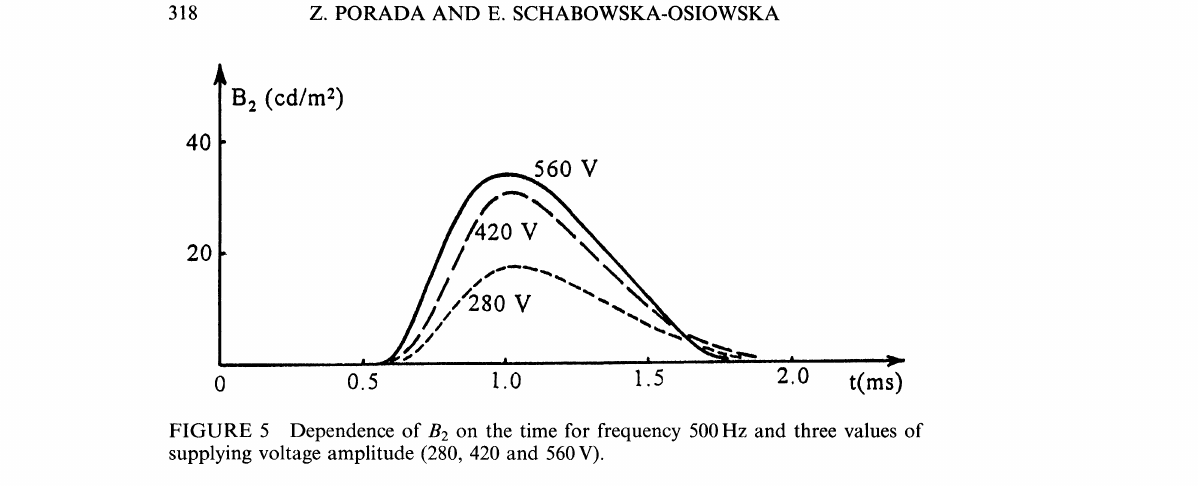
FIGURE 5 Dependence of B2 on the time for frequency 500 Hz and three values of supplying voltage amplitude (280, 420 and 560